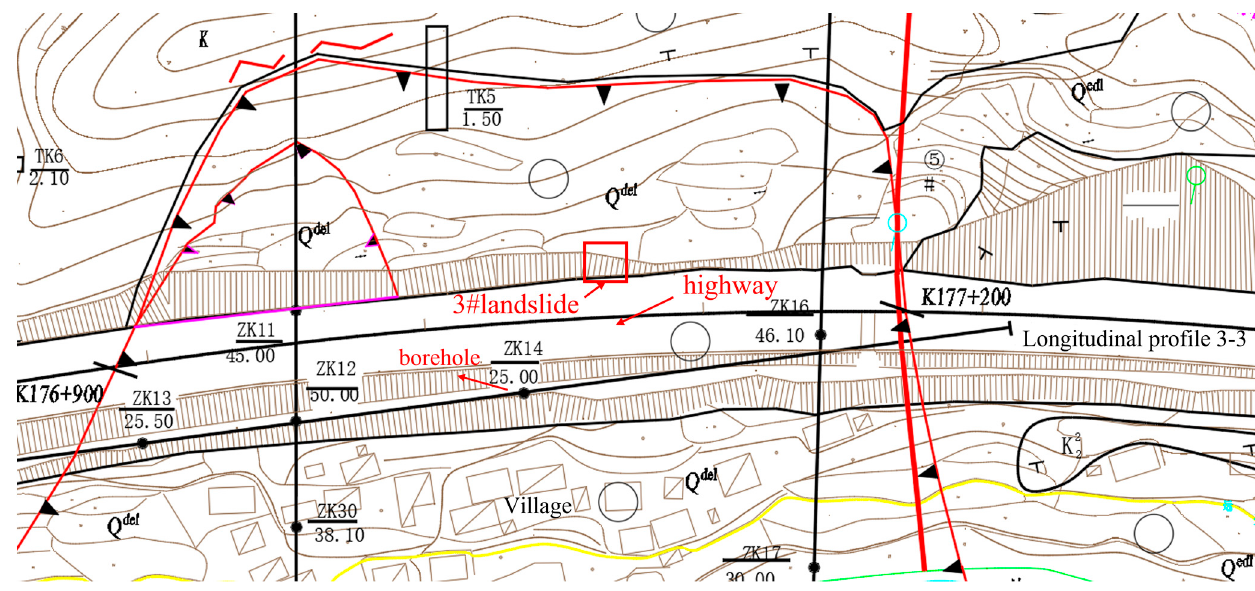
Figure 2. Geological map of the landslide section.